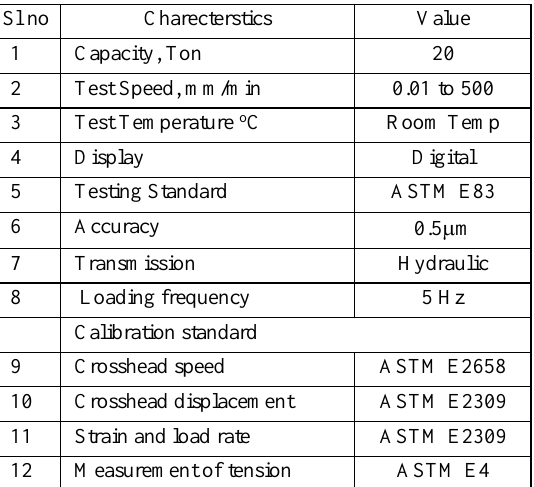
Table 2. Standard specifications of UTM